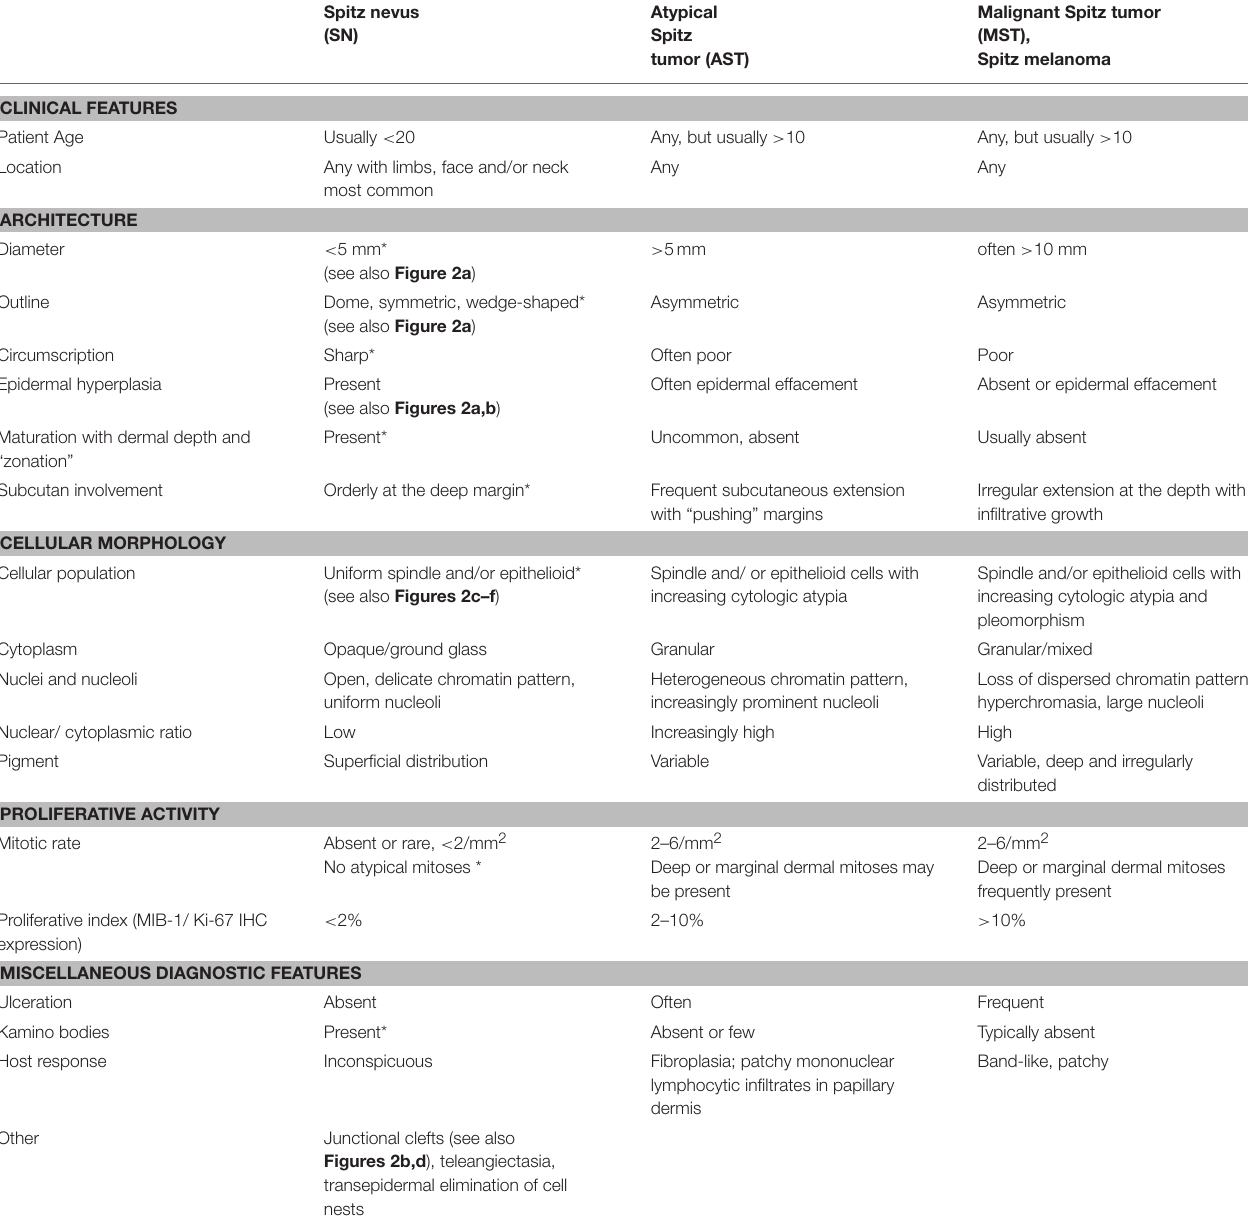
TABLE 1 | Clinical and histopathological features of spitzoid